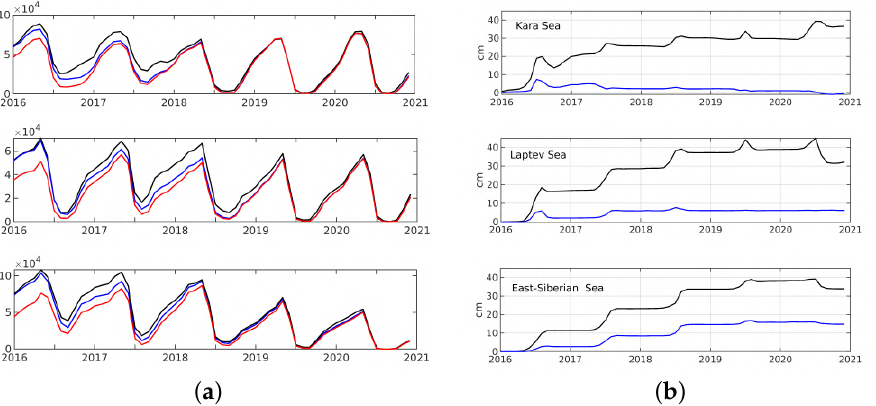
Figure 19. Sensitivity of sea ice volume to initial state of sea ice and ocean during five year in the region 75–81 ◦ N: ( a ) time series of sea ice volume (km 3 ) ( b ) estimate of the difference in accumulated ice thickness due to the reduction in the melting rate at the ice-ocean interface in summer for experiments B11 and B33 compared to experiment A0. Upper panels represent Kara Sea (60–100 ◦ E), middle panels—Laptev Sea (90–140 ◦ E), lower panels—East Siberian Sea (140–180 ◦ E). Red line—A0 experiment, blue line—B11, black